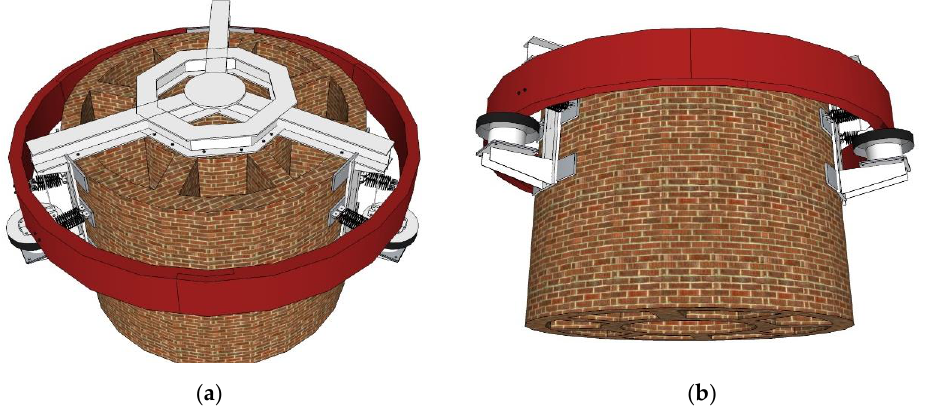
Figure 4. Proposed second configuration with the TMD located at the top of the chimney: ( a ) detail of the TMD support steel structure, and ( b ) a view of the damping devices.